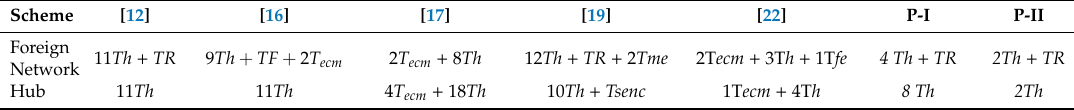
Table 6. Comparison of the scheme computation cost.